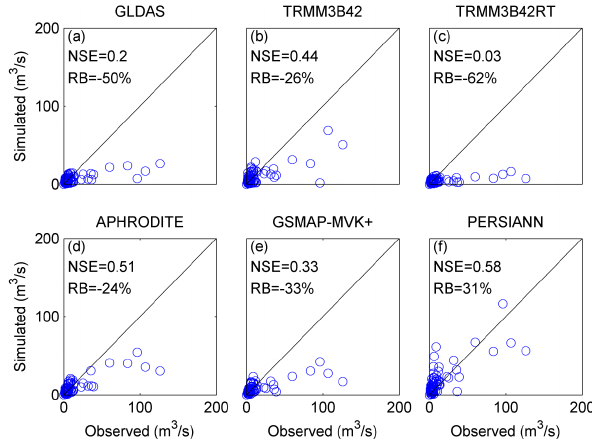
Figure 12. Scatter plots of simulated flows with WEB-DHM against gauge observations at a monthly scale.